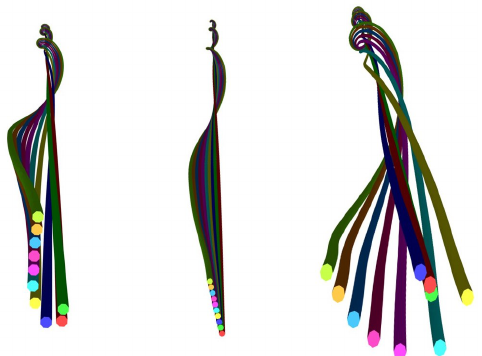
Figure 15. Arrangement of fibres in single row of different layers.